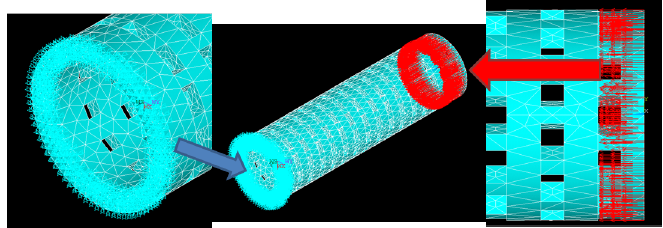
Figure 10. Fixation and force application